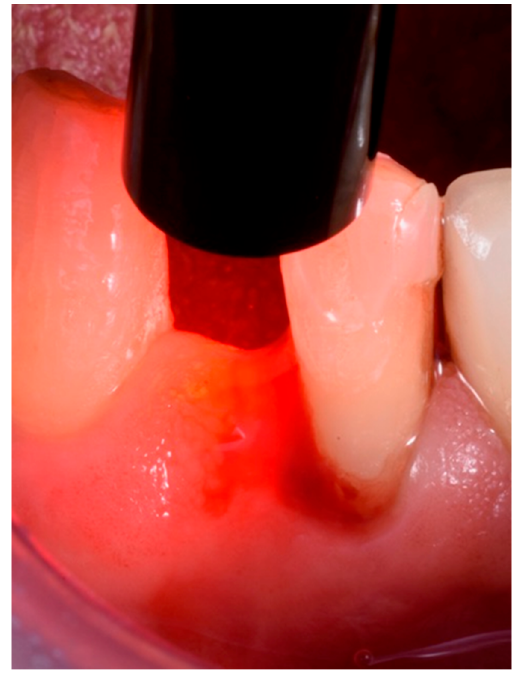
Figure 2. TL-01 LED red light applied to the treated site into which the Aladent ® gel was inserted.